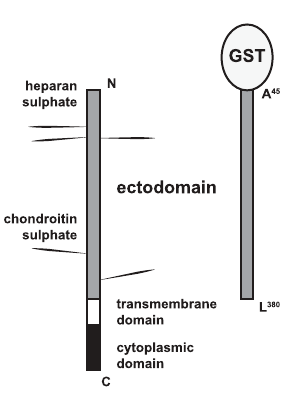
Figure 1. Syndecan-3 and S3ED-GST structures. Diagrammatic representation of the syndecan-3 fusion protein (S3ED) used in this study. The entire length of the syndecan-3 extracellular core protein (A 45 -L 380 ) was fused at the N-terminus to GST.